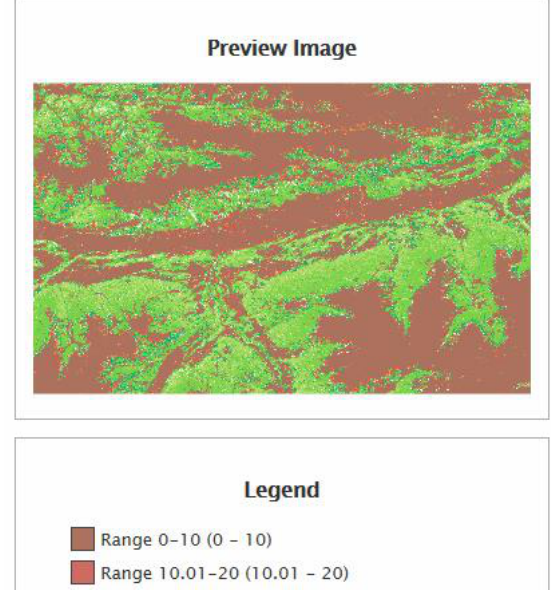
Figure 6. The legend applied to the image as created by the Legend Designer feature